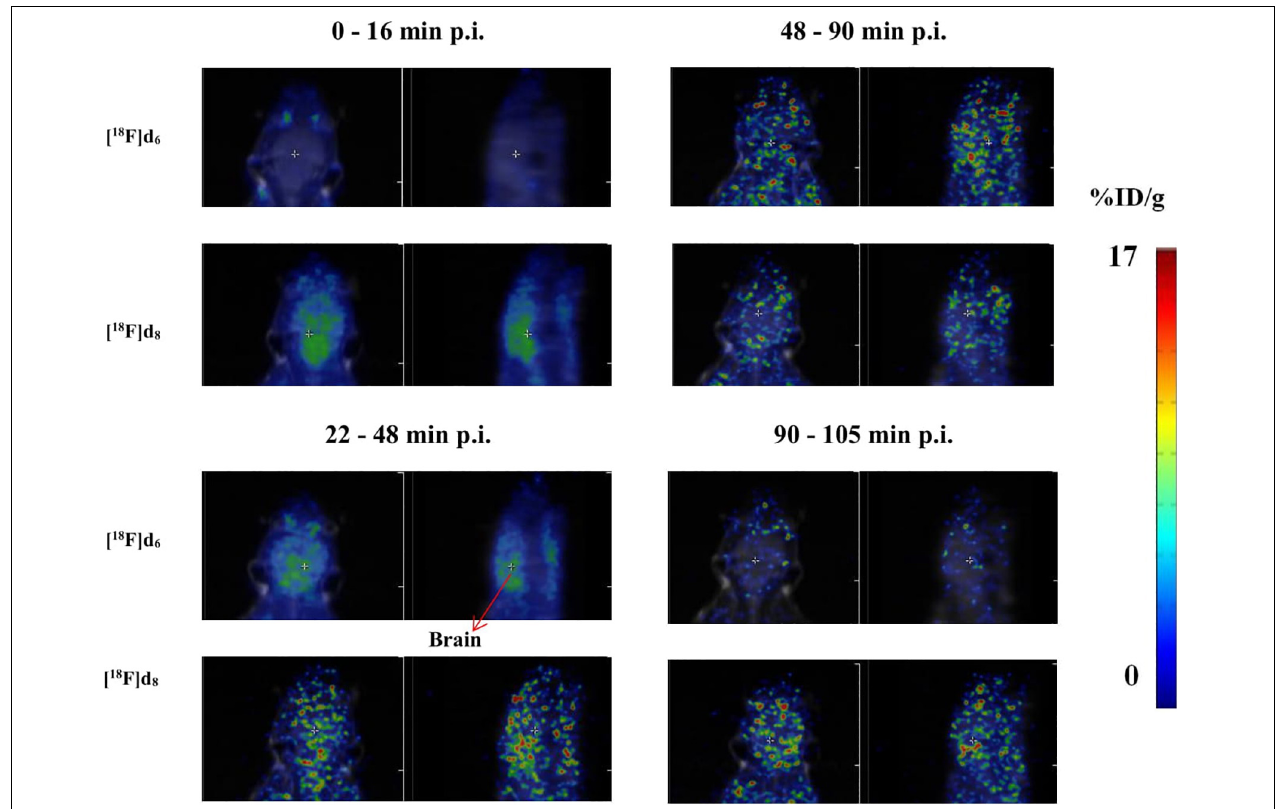
FIGURE 12 | Representative axial and sagittal images of the brain accumulation of [ 18 F]d 6 and [ 18 F]d 8 displayed as